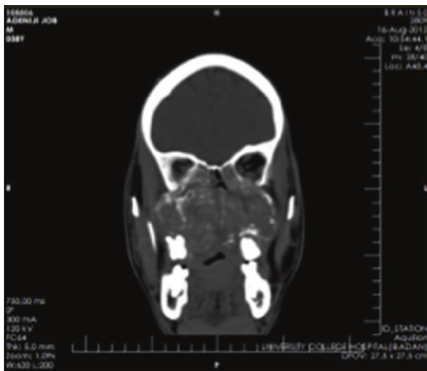
Figure 2: Axial computerized tomography showing a mass destroy- ing the maxilla and the nasal tissues.